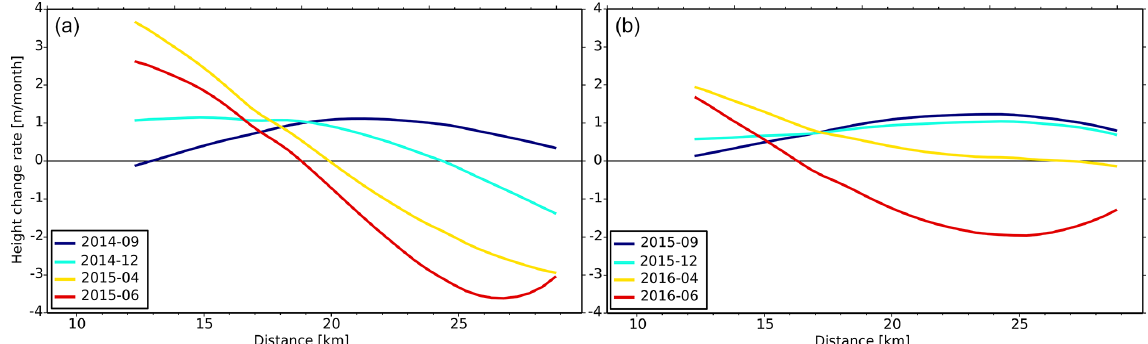
Figure 15. Dynamically caused ice-height changes derived from velocity profiles along a flow line for selected months during ice flow acceleration 2014/2015 (a) and 2015/2016 (b) . The distance is measured from the 1916 glacier front